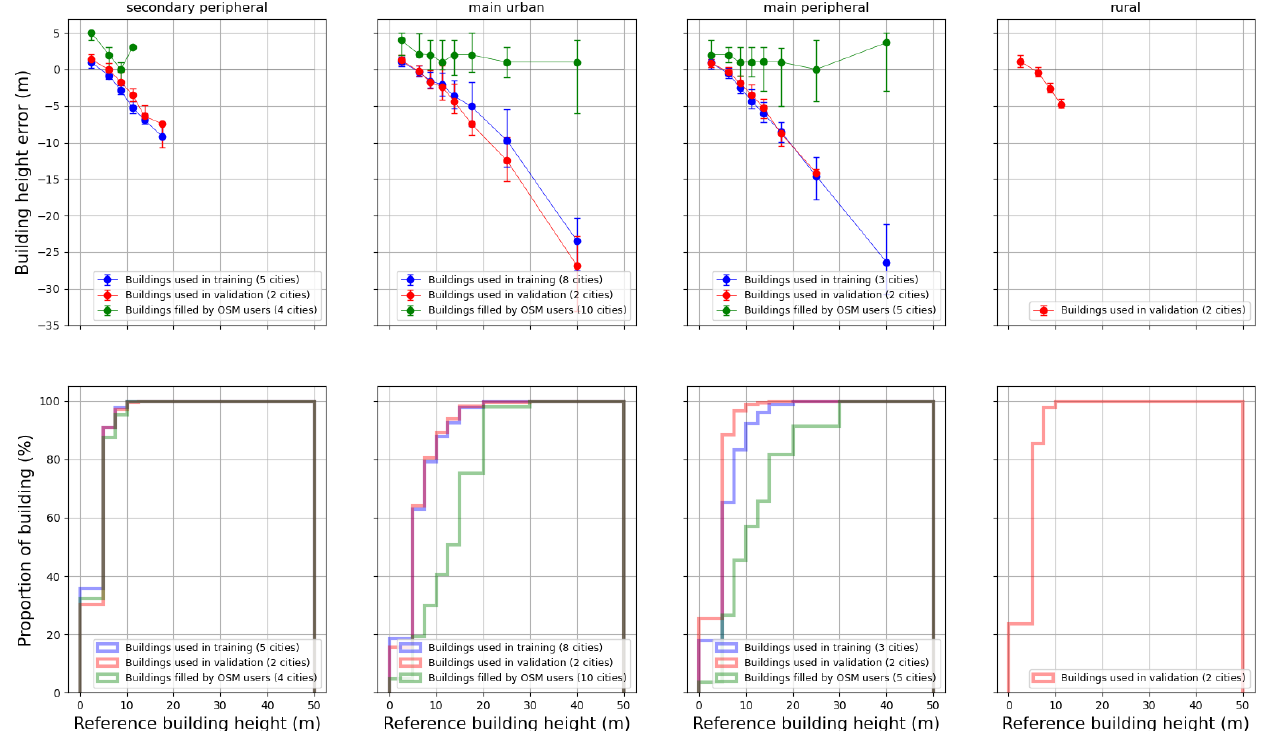
Figure 7. On the top: building height errors (Err model and Err user ) versus reference building height ( H OSM , true ) for each type of city. The dots represent the median, while the whiskers are the 1st and 3rd quartiles. On the bottom: cumulated distribution of reference building height ( H OSM , true ) for each type of city. The intervals used for the reference building height (the abscissa) are based on the following values: 0, 5,